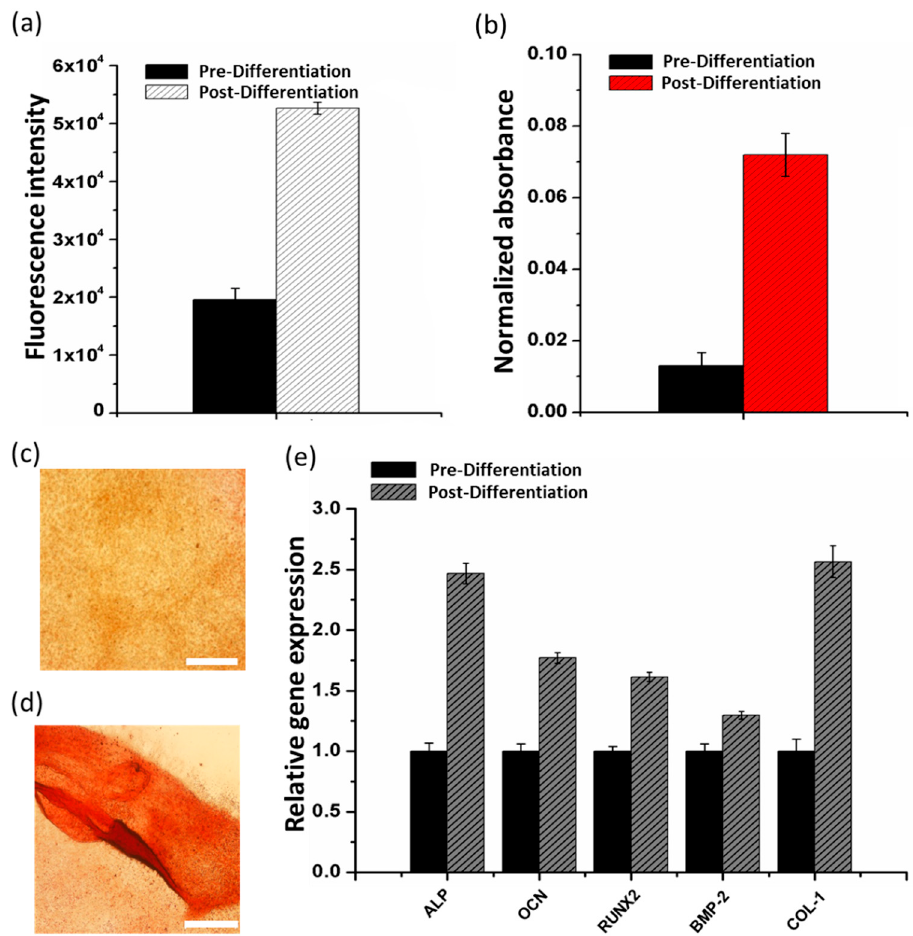
Figure 4. Osteogenesis on the Alginate/FmocFF composite hydrogel. ( a ) Quantification of Alkaline Phosphatase (ALP) activity of MC3T3-E1 preosteoblast cells 3 days after seeding on Alginate/FmocFF composite hydrogel and following 14 days of osteogenic differentiation. ( b ) Quantification of calcification by Alizarin red staining of MC3T3-E1 preosteoblast cells 3 days after seeding on Alginate/FmocFF composite hydrogel and following 14 days of osteogenic differentiation. ( c , d ) Optic microscope images of MC3T3-E1 preosteoblast cells stained with Alizarin red ( c ) 3 days after seeding on Alginate/FmocFF composite hydrogel and ( d ) following 14 days of osteogenic differentiation. Scale bar = 500 µm. ( e ) Relative mRNA expression of osteogenic genes (ALP, OCN, RUNX2, BMP-2, and Col-I) was quantitated by RT-qPCR analysis of MC3T3-E1 cells 3 days after seeding on Alginate/FmocFF composite hydrogel and following 14 days of osteogenic differentiation.